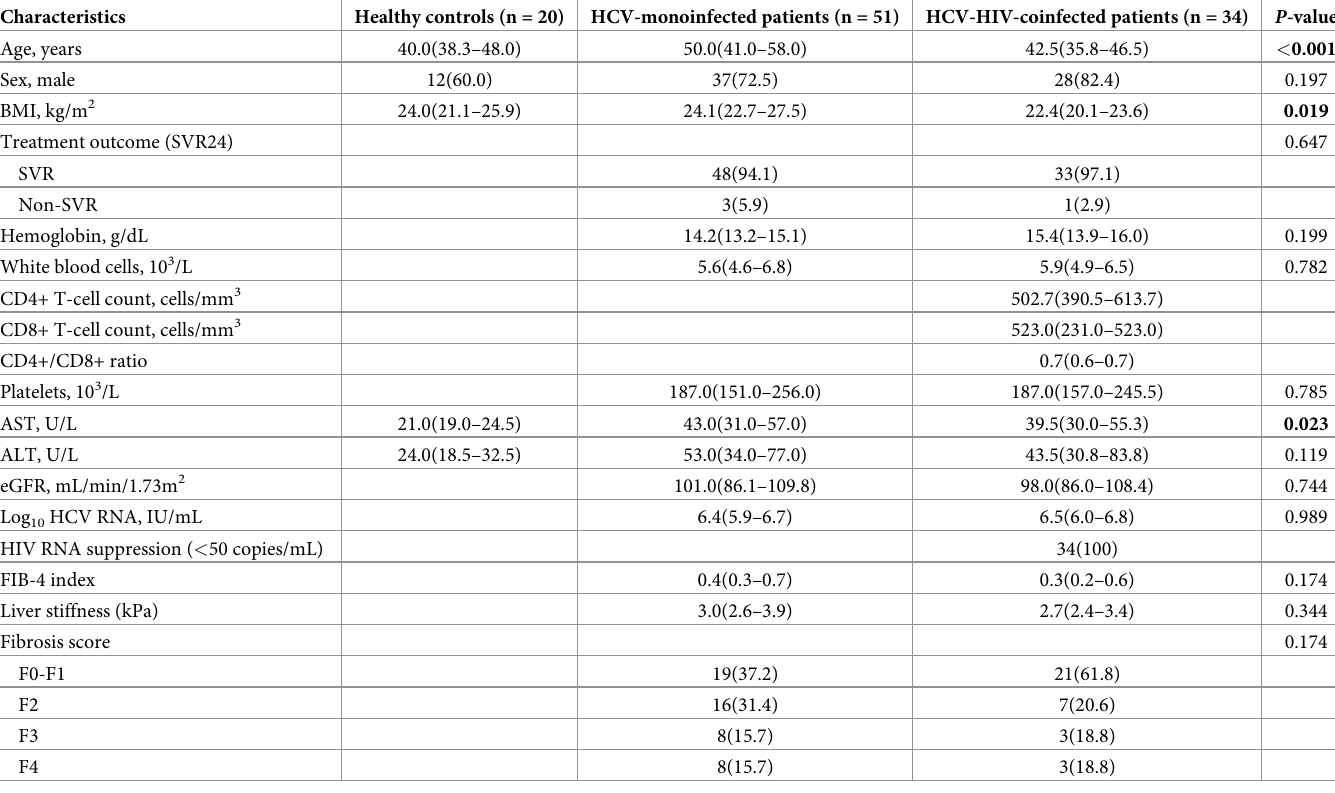
Table 1. Baseline demographic and clinical